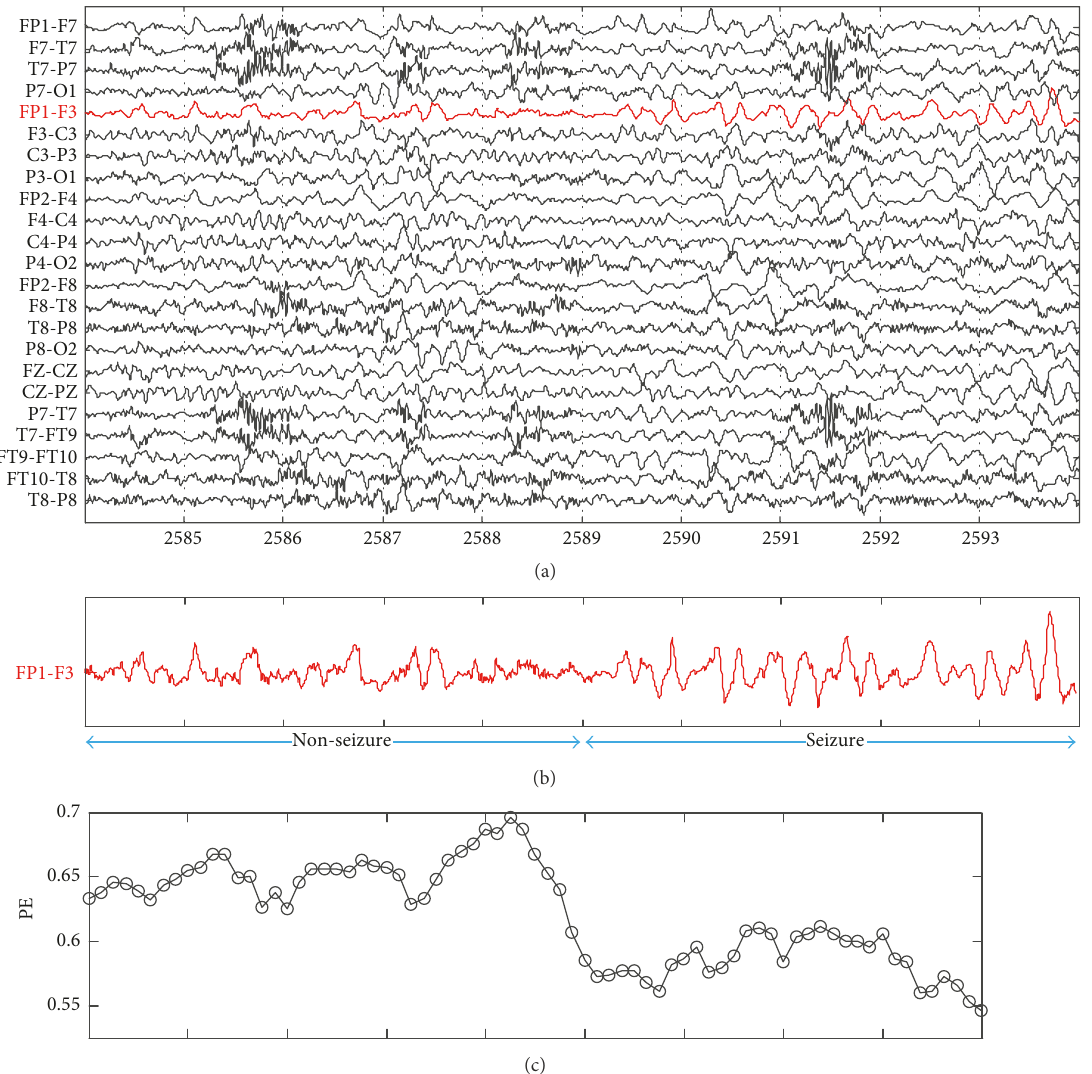
Figure 2: (a) The continuous multichannel EEG recording (23 channels) with a seizure in Patient I. (b) The EEG channel FP1-F3 involved in seizure activity. (c) Time evolution of the values of PE for FP1-F3 channel. The length of window is 1s, and the step is 1/8s. Almost all of the PE values in seizure state are lower than those in seizure-free